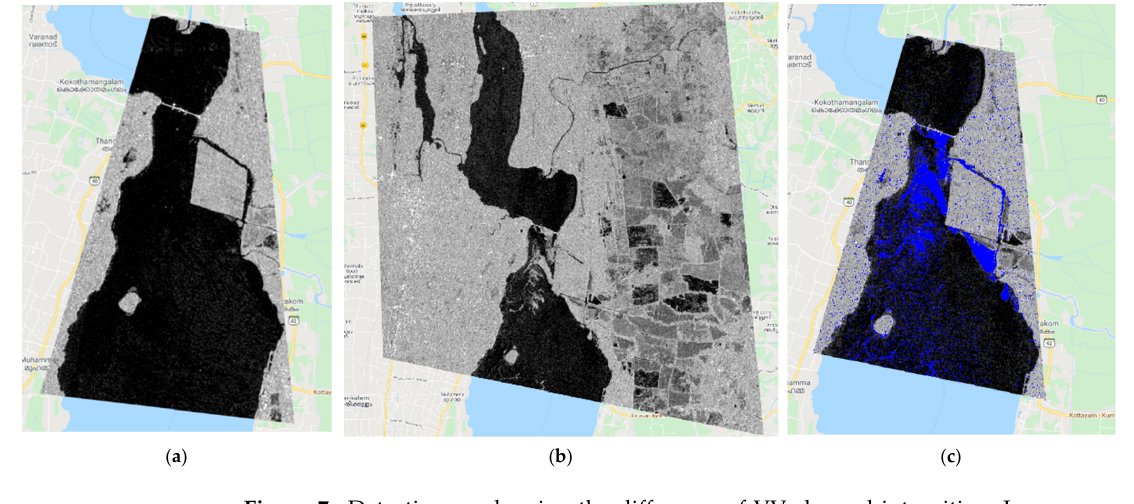
Figure 7. Detection mask using the difference of VV channel intensities. Images compared: ( a ) 2 November 2019 and ( b ) 19 January 2020. ( c ) Detection mask using previous images. (Sentinel-1, credits: ESA).